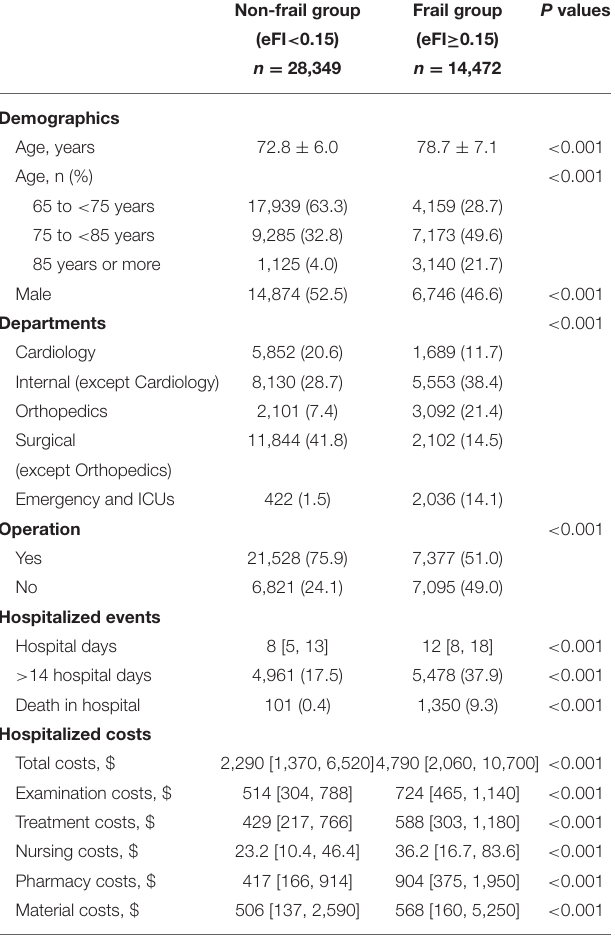
TABLE 2 | Hospitalized events and costs in frail and non-frail groups classified by eFI ≥ 0.15. Non-frail group Frail